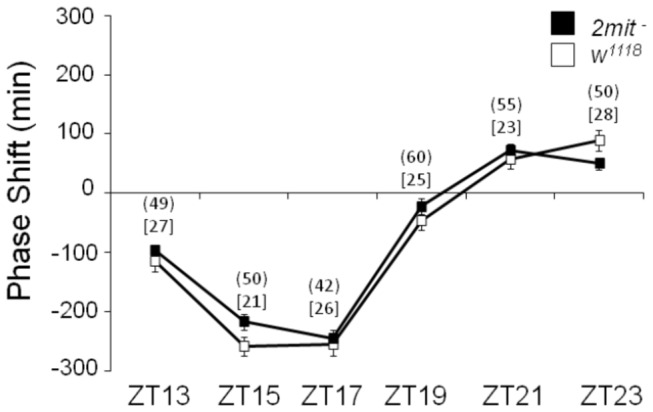
Phase response curve of 2mit
c03963 and w
1118 flies.Analysis of variance genotype X time interactions (ZT): F5,434=1.76 p=0.12, not significant. Advance and delay phase shift responses are represented respectively as positive and negative values. 2mit
-: 2mit
c03963 homozygous mutant flies. Data are expressed as mean ± SEM; (Ns) and [Ns] indicate the number of 2mit
c03963 and w
1118 flies analyzed, respectively.